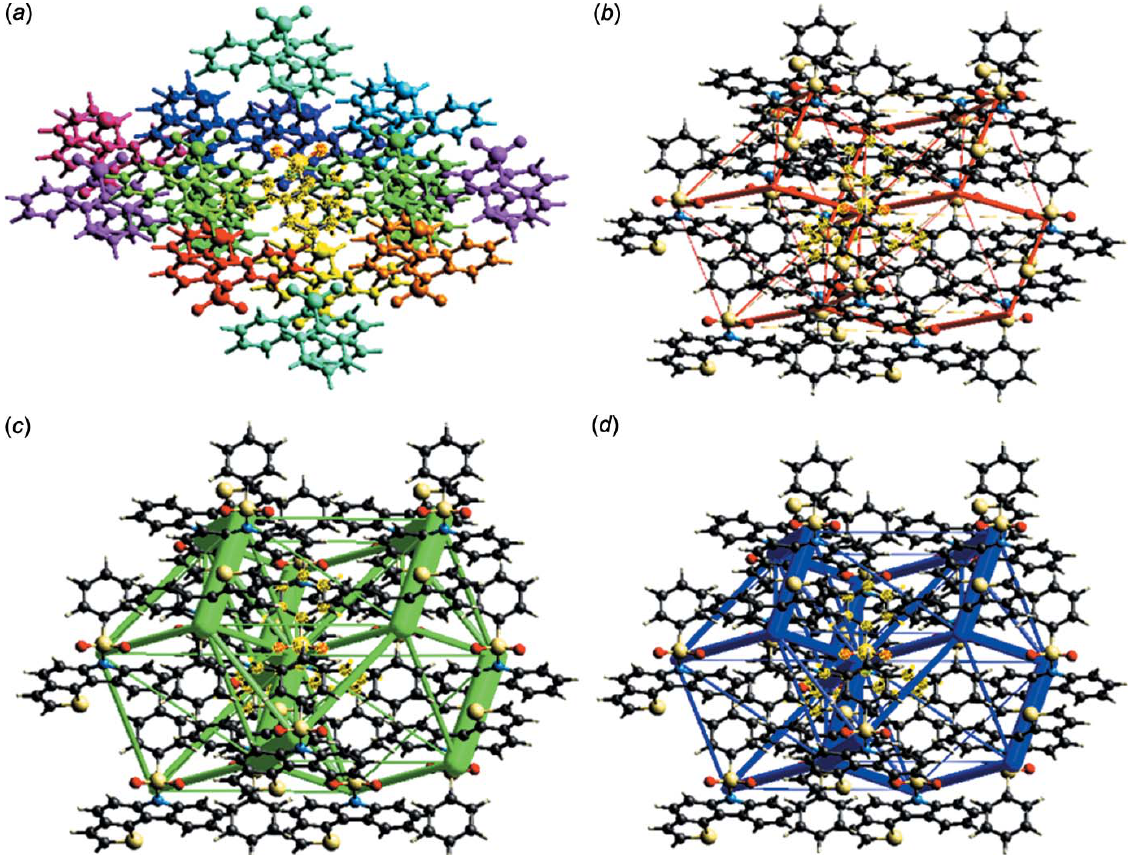
Figure 5 ( a ) Interactions between the selected reference molecule (highlighted in yellow) and the molecules present in a 3.8 A˚ cluster around it, ( b ) Coulomb energy framework, ( c ) dispersion energy framework and ( d ) total energy